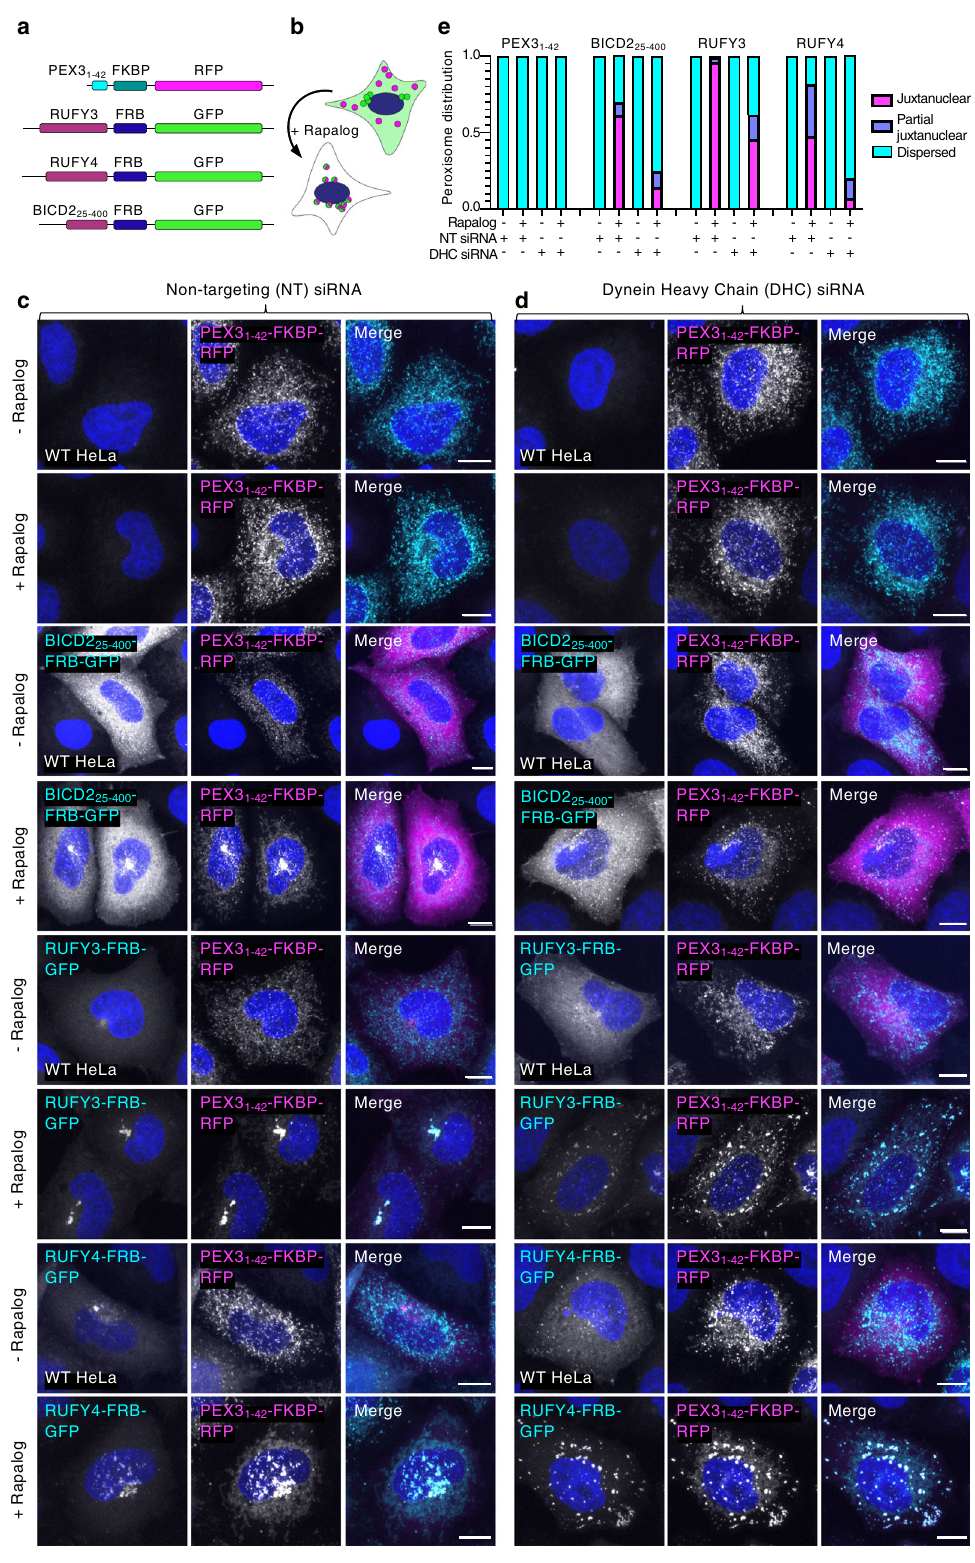
Cell culture and treatments . HeLa (Cat# CCL-2, ATCC) and HEK293T (Cat# 632180, Takara Bio) cells were maintained in Dulbecco ’ s Modi fi ed Eagle ’ s Medium (DMEM) (Cat# 112-319-101, Quality Biological) with 10% fetal bovine serum (35- 011-CV, Corning), 50 U/mL penicillin, 50 μ g/mL streptomycin (Cat# 30002-CL, Corning) (CDMEM) and incubated in 5% CO 2 and 37 °C. Lipofectamine 2000 (Cat# 11668019, Thermo Fisher) was used for transfections according to the manufacturer ’ s protocol. Brie fl y, for immuno fl uorescence microscopy and